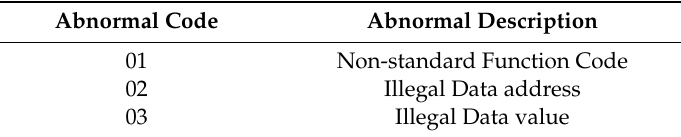
Table 1. Abnormal codes and abnormal descriptions.